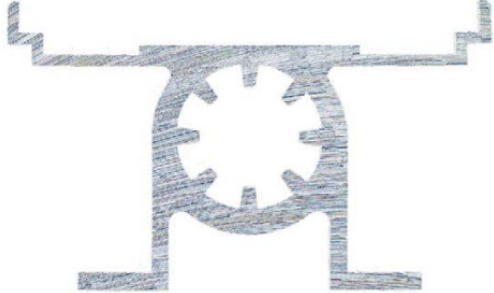
Figure 10. The cross-sectional view of CHAPS receiver tested in [92]. Reprinted with permission from Ref. [92]. 2005, Elsevier.